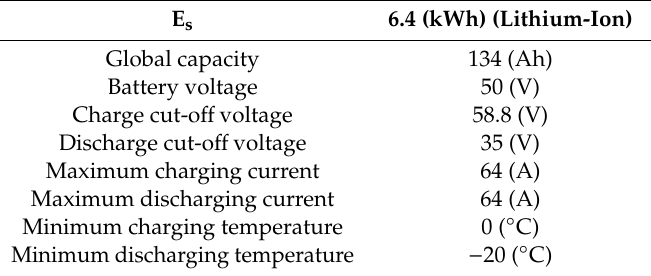
Table 3. Main characteristics of the storage system.